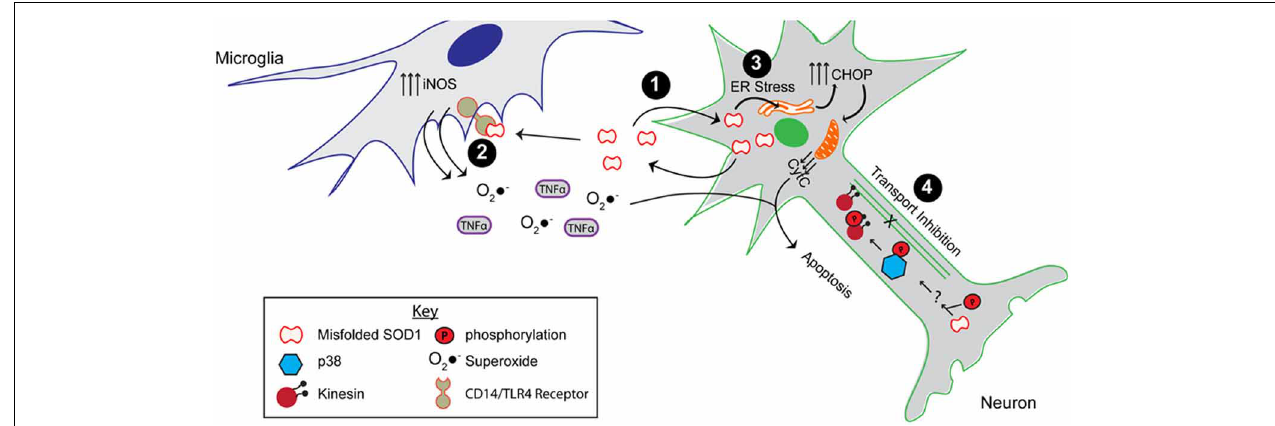
FIGURE 5 | The toxic properties shared by ALS-linked mutant SOD1 and modified WT SOD1. As shown, misfolded SOD1, resulting from mutations or aberrant post-translational modifications, causes the protein to engage in aberrant interactions. (1) Misfolded SOD1 is both secreted, possibly through chromogranins, and taken up from the extracellular environment. (2) Extracellular misfolded SOD1 activates microglia by binding to the CD14/TLR4 receptor, thereby elevating nitric oxide synthase (iNOS) activity as well as secretion of superoxide anion